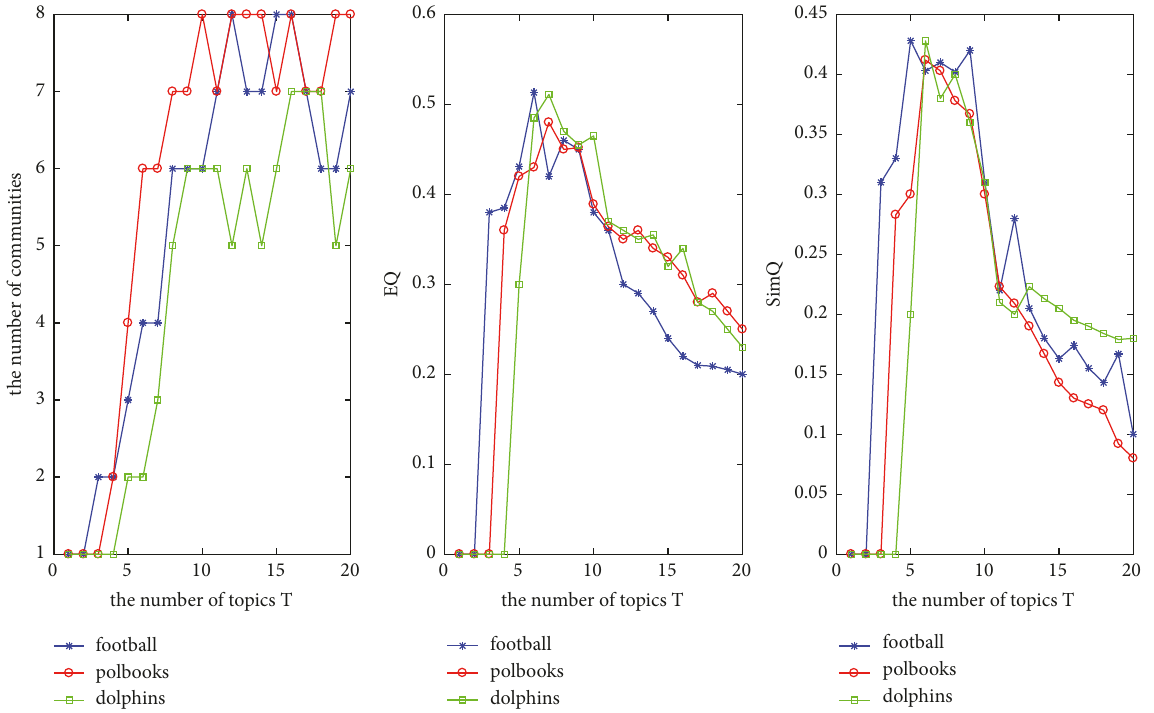
Figure 5: The performance of detected communities with 𝑇 .